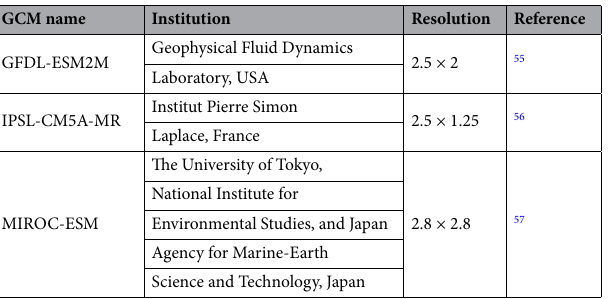
Table 2. CMIP5 GCMs used as initial and boundary conditions in the downscaling